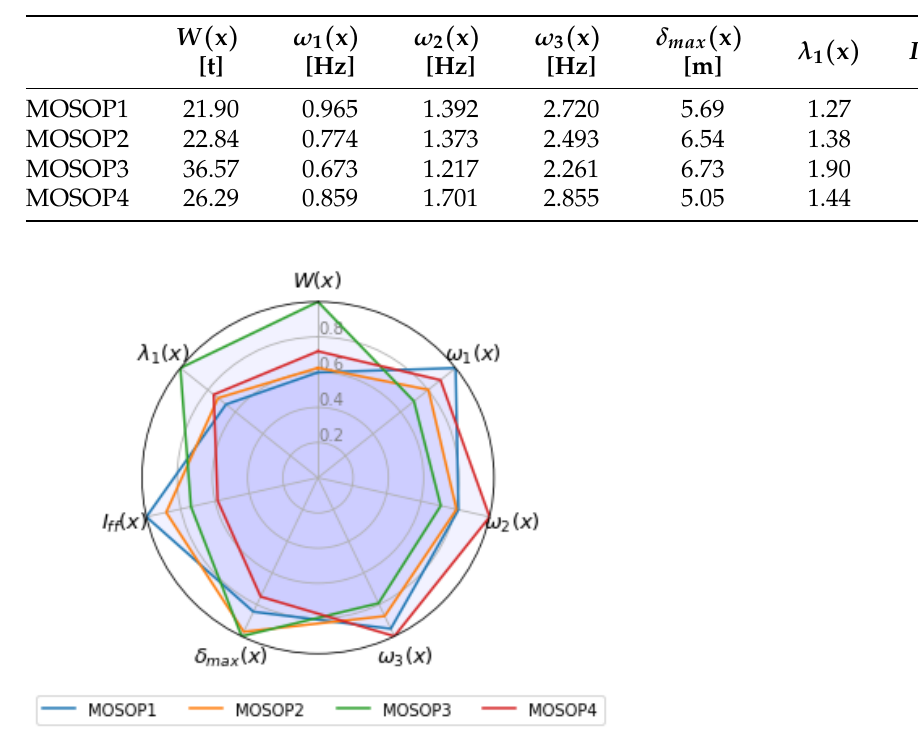
Figure 25. Radar plot comparison of normalized objective